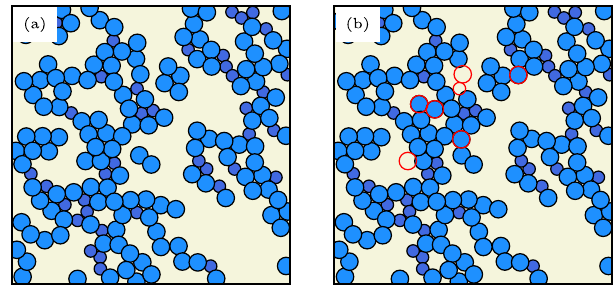
Fig. 2 Visualization of force chain predictions for a prototypical athermal solid. a Force chains (blue) in an athermal solid with n A = n B = 200, obtained through a shear simulation with magnitude of the step strain γ = 0.1 at packing fraction ϕ = 1.0. b Force chains predicted by a graph neural network taking as input the con fi guration of ( a ) before the deformation was applied. Particles misidenti fi ed by the GNN are highlighted in red.